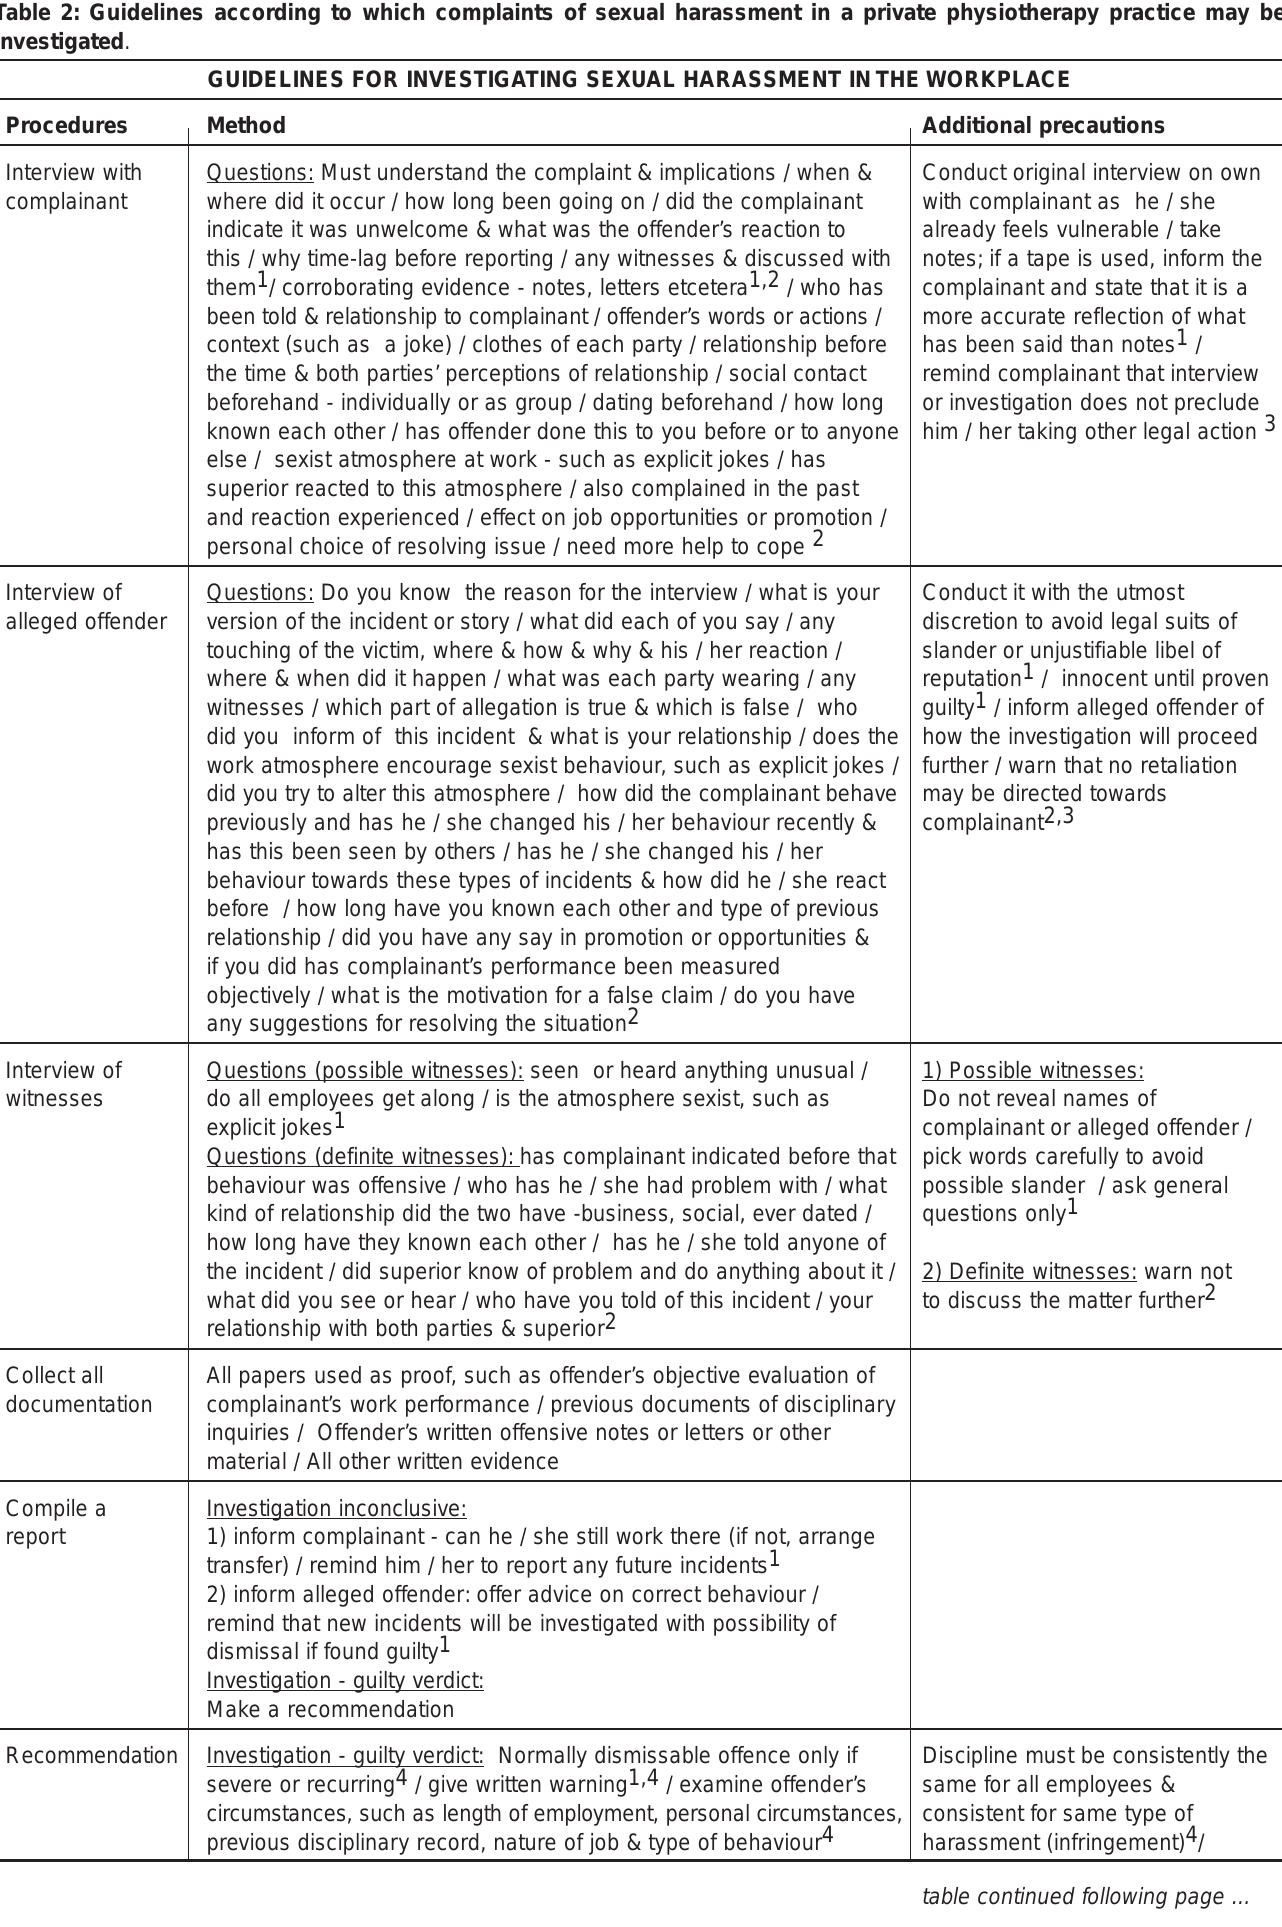
Table 2: Guidelines according to which complaints of sexual harassment in a private physiotherapy practice may be investigated